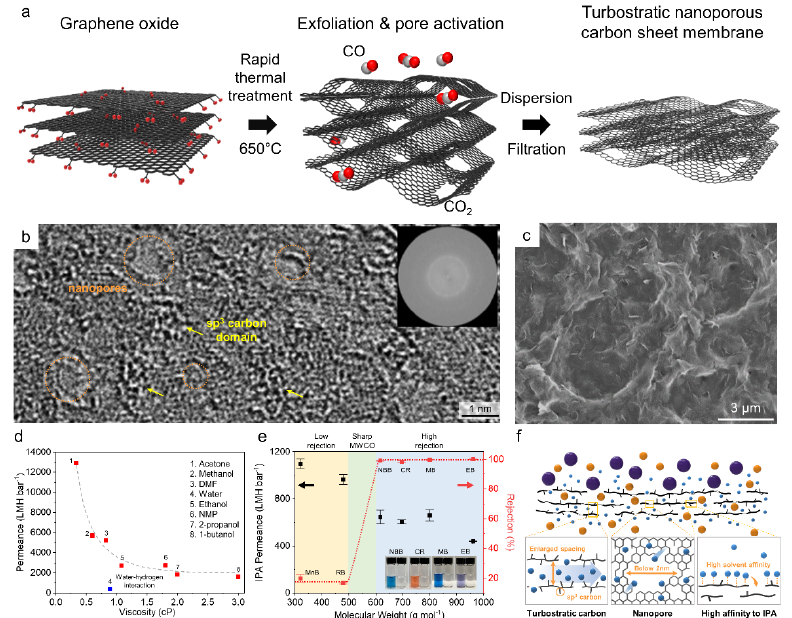
Figure 5. Thermally activated NG for OSN. ( a ) Schematic of the rapid thermal treatment of GO nanosheets for pore generation. ( b ) TEM image of the basal plane of the activated GO and the corresponding FFT image. ( c ) Scanning electron microscopy (SEM) image of surface of the multilayer NG membrane. ( d ) Pure solvent permeance as a function of solvent viscosity. ( e ) Rejection rate of isopropyl alcohol (IPA). ( f ) Schematic of the molecular separation mechanism of the multilayer NG membrane [32]. Copyright 2020 Royal Society of Chemistry.